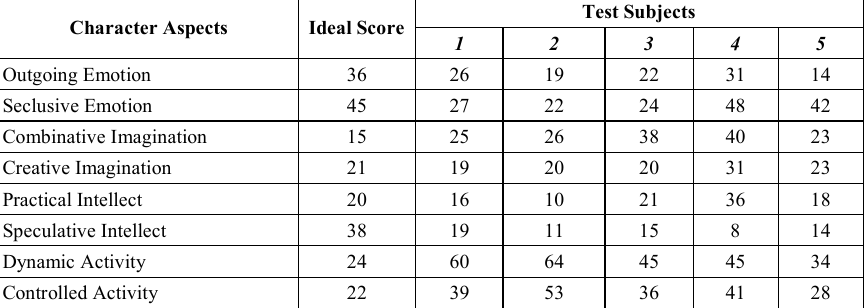
Table 1. Score data sample of five test subjects and the ideal